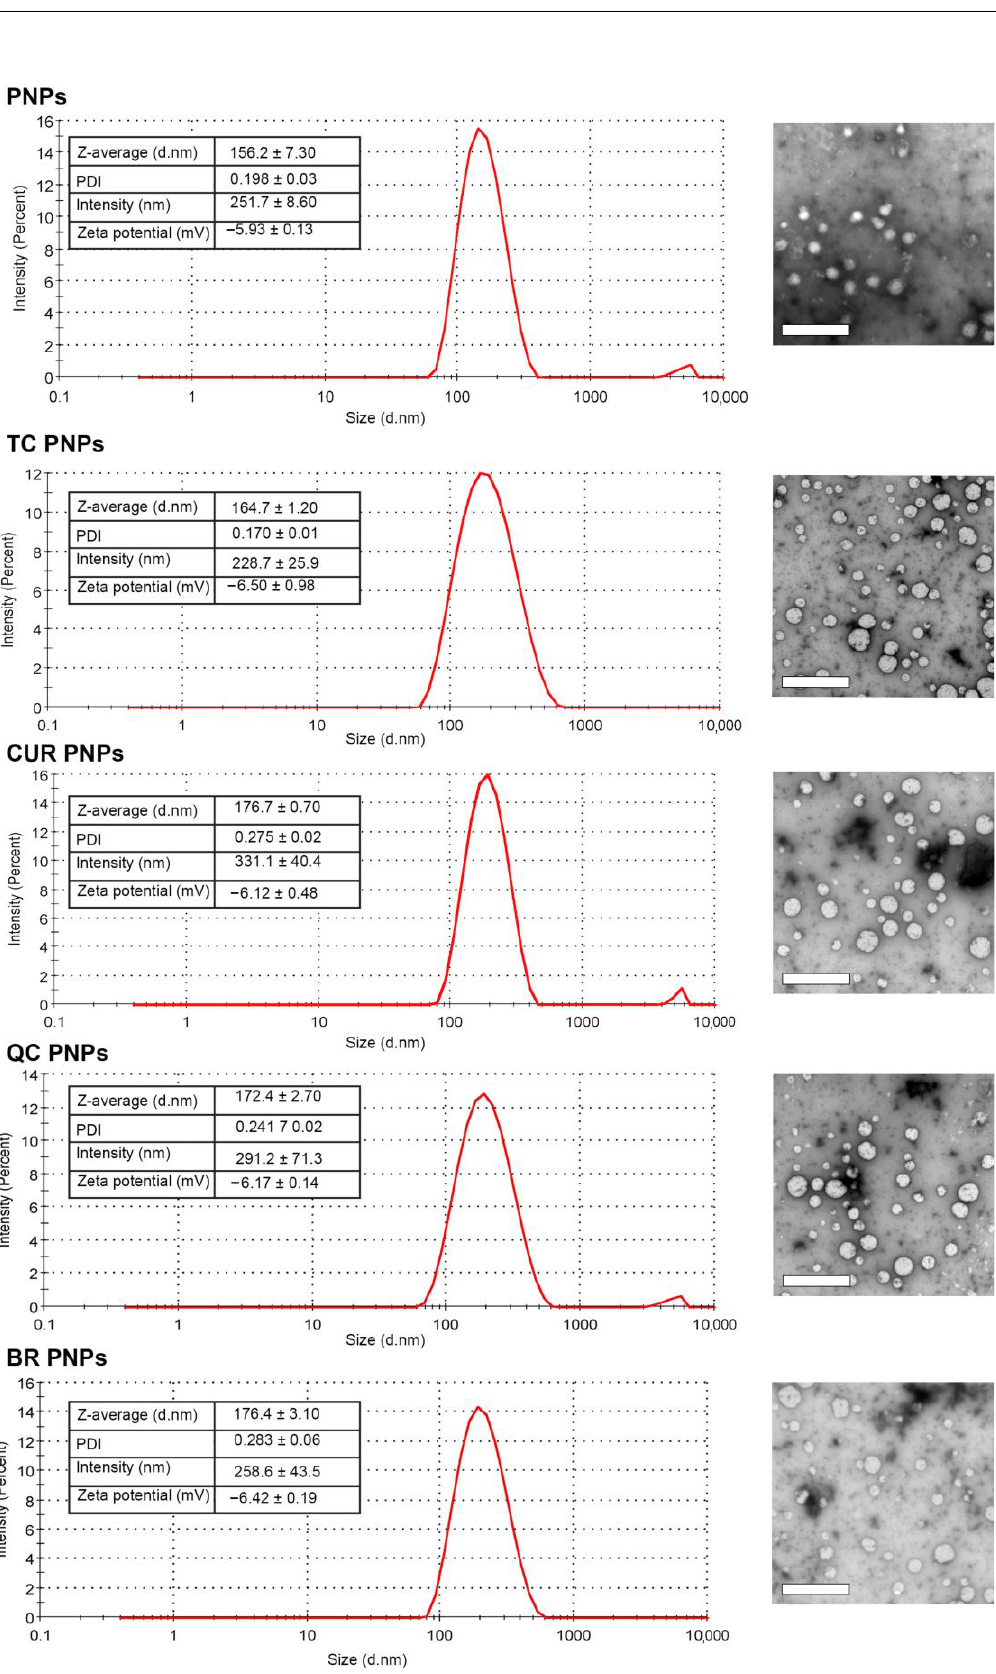
Figure 2. Dynamic light scattering intensity distribution and transmission electron microscopy imaging for unloaded β -LG PNPs, as well as TC-, CUR-, QC- and BR-loaded β -LG PNPs. White scale bars represent 2 µm).